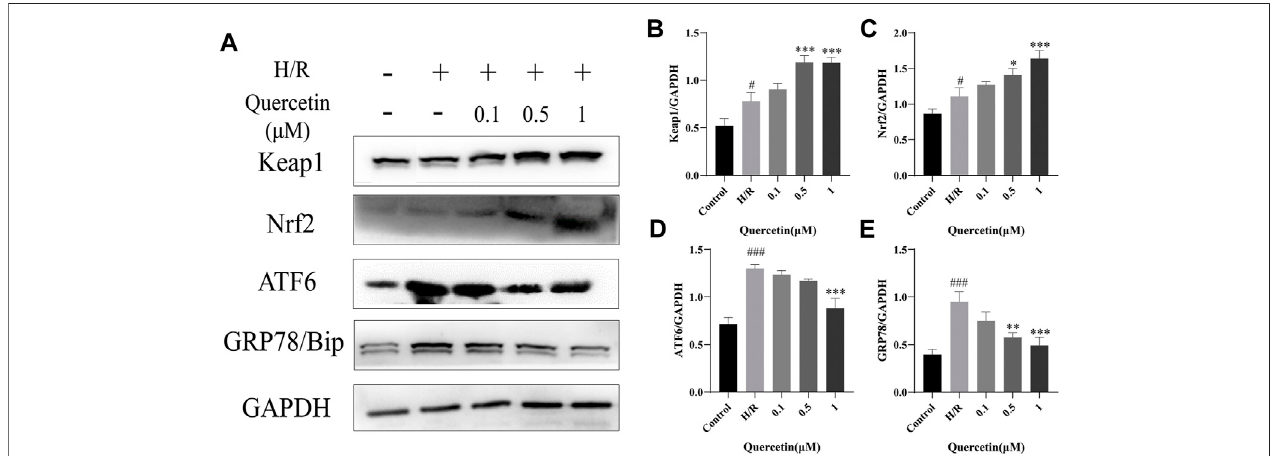
FIGURE 6 | (A) Protein expressions were evaluated with Western blotting (B) Keap1 quanti fi cation of Western blotting result was calculated (C) Nrf2 expression quanti fi cation of Western blotting result was inhibited (D) ATF6 expression data was analyzed (E) GRP78 expression data was analyzed. # p < 0.05, ### p < 0.001 compared to control group; * p < 0.05, ** p < 0.01, *** p < 0.001 compared to H/R group. μ M: μ mol/L; Keap1: Kelch Like ECH Associated Protein 1; Nrf2: Nuclear factor E2-related factor 2; ATF6: Activating transcription factor 6; GRP78: Glucose-regulated protein 78; H/R: Hypoxia and reoxygenation, n (cid:2) 3.